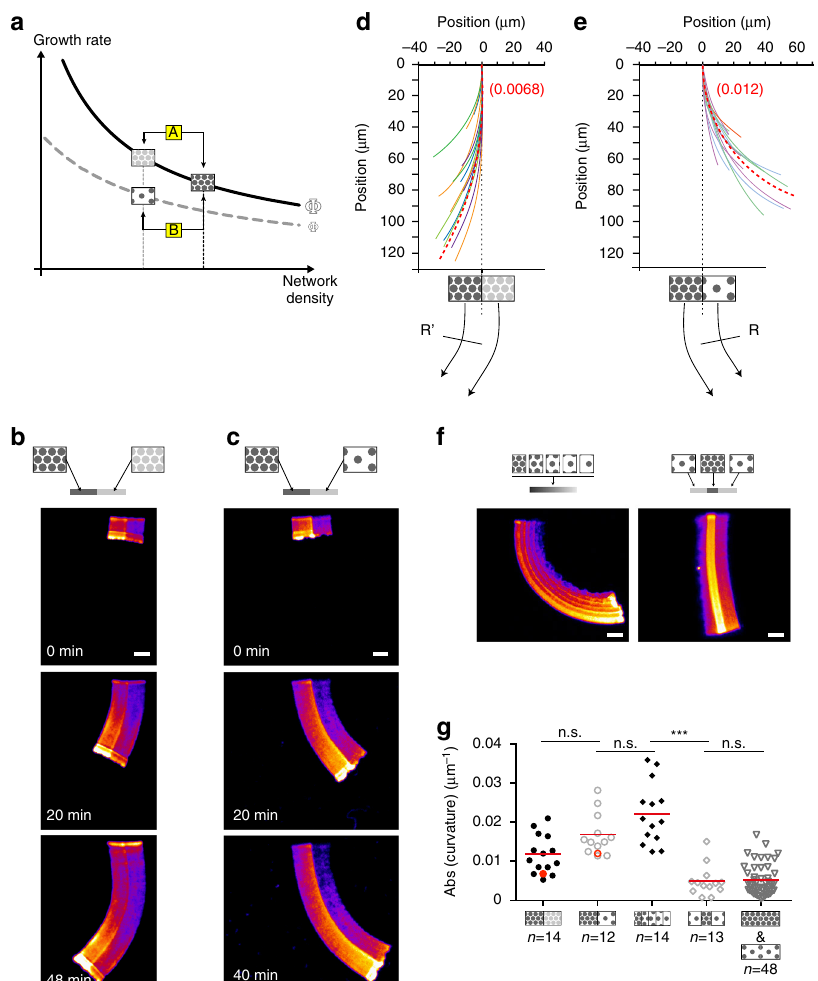
Fig. 6 Density and geometrical organization interplay to control the steering of heterogeneous networks. a Cartoon predicting heterogeneous actin- network-growth behavior. If the two densities are generated by the same pattern family (i.e. two positions along the same curve; Case A), the steering is predicted to be always towards the denser network; if the two densities are generated by two different pattern families (two positions from two different curves Case B), the steering can be towards the sparser network. Solid curve refers to networks generated by high -spot-density patterns; dotted curve refers to networks generated by low -spot-density patterns. Double-density branched actin networks were polymerized on heterogeneous patterns. Patterns consisted either in an array of spots of the same density, with one half coated with high and the other half with low amounts of NPFs per spot b , or in an array of spots of two distinct densities both coated with the same amount of NPFs per spot c . Network curvatures, represented by the traces of the boundary between high- and low-density sides, were reported at 40 min of assembly in d , e , referring to b , c respectively. The red dashed line in d , e represents the predicted curvature according to the model. f Complex heterogeneous patterns were generated. A gradient of high- to low-spot density ( left panel ) or a symmetric and alternate low-high-low spot density ( right panel ). g LMs were polymerized on nucleation zones as indicated, and their curvature measured. High and low densities were 6.6 and 2.5 spots µ m − 2 , respectively. Gradually sparse patterns were a series of 3 × 5 µ m 2 rectangles of decreasing spot density (from 8.3 to 2 spots µ m − 2 ). The “ low-high-low ” patterns were a series of 3 × 10, 3 × 6, 3 × 10 µ m 2 rectangles of 2.5, 6.6, 2.5 spots µ m − 2 , respectively. *** p < 0.001, multiple comparison Š ídák method. Scale bars are 15 µ m (see also Supplementary Fig. concentrations (Fig. 4c, black dots ). This result was consistent with the local monomer depletion hypothesis, in that the LMs with higher fi lament densities will consume more actin mono- mers than those with lower fi lament densities. Processing the data through the actin network growth-rate model using the para- meters derived from the preceding experiments, the decrease in the LM growth rate was satisfactorily simulated as a function of the increased density of the network (Fig. 4c, red line ). We therefore concluded that for nucleation areas, which have the same spot densities, the growth of higher fi lament density net- works leads to higher local monomer depletion, which in turn slows down the network-growth rate.